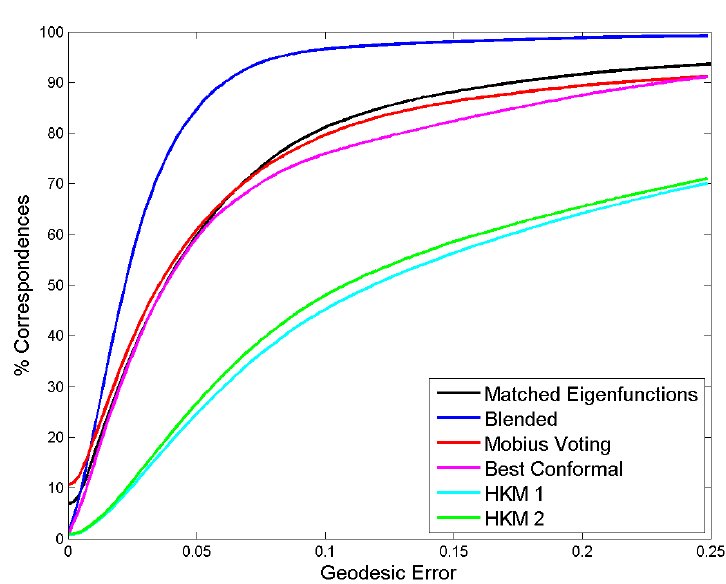
Figure 7. Evaluation of the proposed correspondence framework applied to shapes from the TOSCA database, using the protocol of